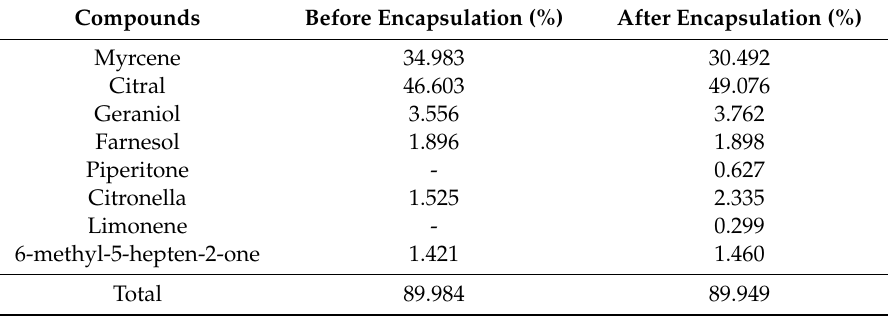
Table 5. Comparison of lemongrass essential oil compositions before and after encapsulation. Compounds Before Encapsulation (%) After Encapsulation (%) Myrcene